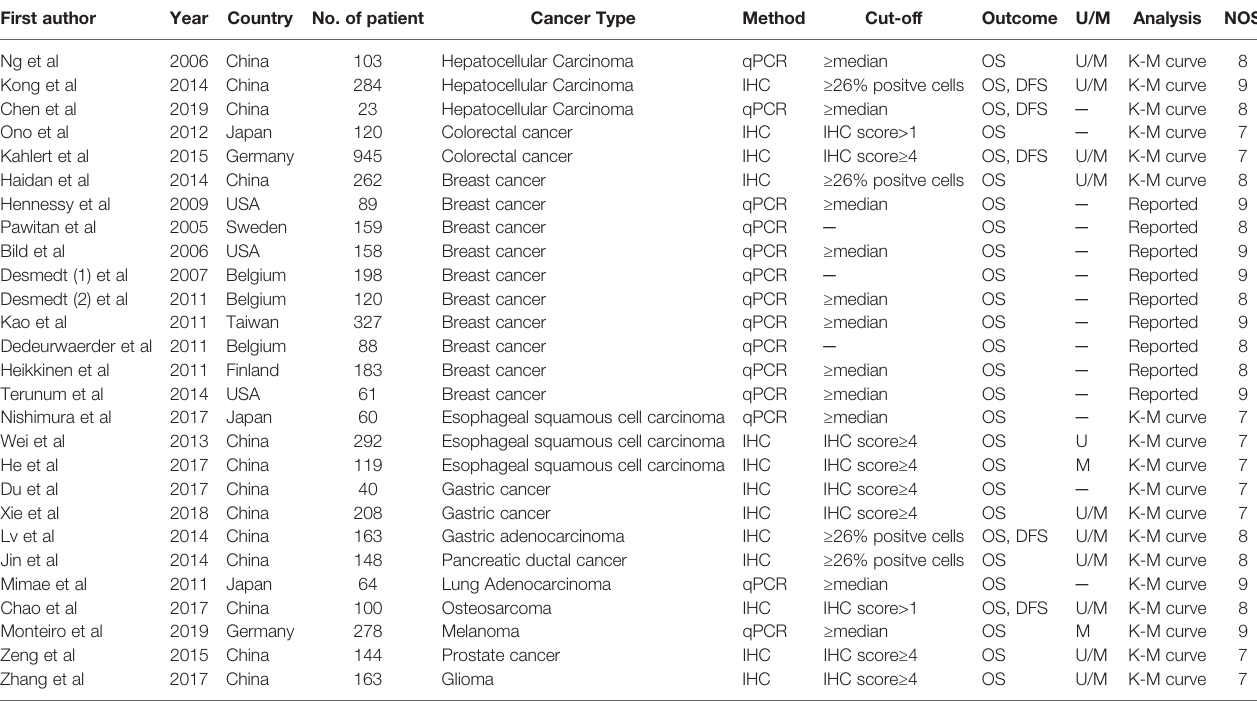
TABLE 1 | Characteristics of studies in this